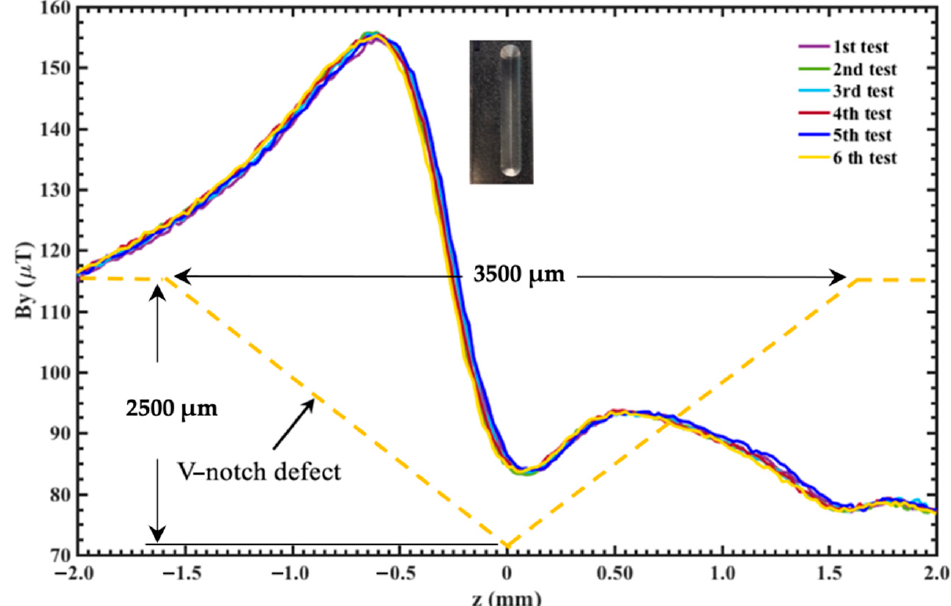
Figure 12. Variation of normal MMM signals measured around the fifth V-shaped notch (3500 µ m width and 2500 µ m depth) of the ASTM-A36 steel pipe, which were measured using six experimental tests. Table 2 indicates the values of minimum tangential MMM signals at the center of the V-shaped notches, as well as the maximum and minimum normal MMM signals at the edges of each notch. Furthermore, the maximum variations of tangential MMM signals around five notches are indicated in Table 3. Tangential MMM signals had variations of 14.32 µ T ± 1.62 µ T and 16.08 µ T ± 1.86 µ T close to center of the first and second notches, respectively. Moreover, the third notch shows a higher tangential MMM signal shift (66.73 µ T ± 1.13 µ T) in comparison with those of the first two defects. In the fourth notch, we observed a tangential MMM signal variation of 55.13 µ T ± 1.33 µ T, which is higher than those of the first and second notch. The fifth notch had a change of tangential MMM signal of 68.75 µ T ± 1.10 µ T, which is higher than that registered by the other defects. In addition, Table 3 contains the normal MMM signal variations around the two edges of the five V-shaped notches, considering the maximum and minimum peak values. In the first notch, a shift (27.95 µ T ± 1.14 µ T) in the normal MMM signal is registered between the two edges of the defect. The second notch has a normal MMM signal shift of 26.4 µ T ± 0.54 µ T. For the third and fourth notches, the normal MMM signal variations were 62.63 µ T ± 0.50 µ T and 51.98 µ T ± 0.64 µ T, respectively. On the other hand, the fifth notch achieves a maximum normal MMM signal shift of 71.37 µ T ± 0.72 µ T. For these normal MMM signals, the first and second notches have the lowest tangential MMM signal variation. The first defect (500 µ m depth) generates an alteration of tangential and normal MMM signals around the pipe, which could be used for monitoring its position and size. Figure 13 depicts la maximum variation of tangential MMM signal with respect to the depth of the V-shaped notch. For the first three defects, the maximum variation of this MMM signal increases when the depth increases. For the fourth and fifth defects, the variation of the tangential MMM signal is lower. For instance, the fourth defect has a lower variation with respect to third defect. This could be due to the saturation of the variation fourth defect. Thus, this variation of tangential MMM signal has a nonlinear behavior.